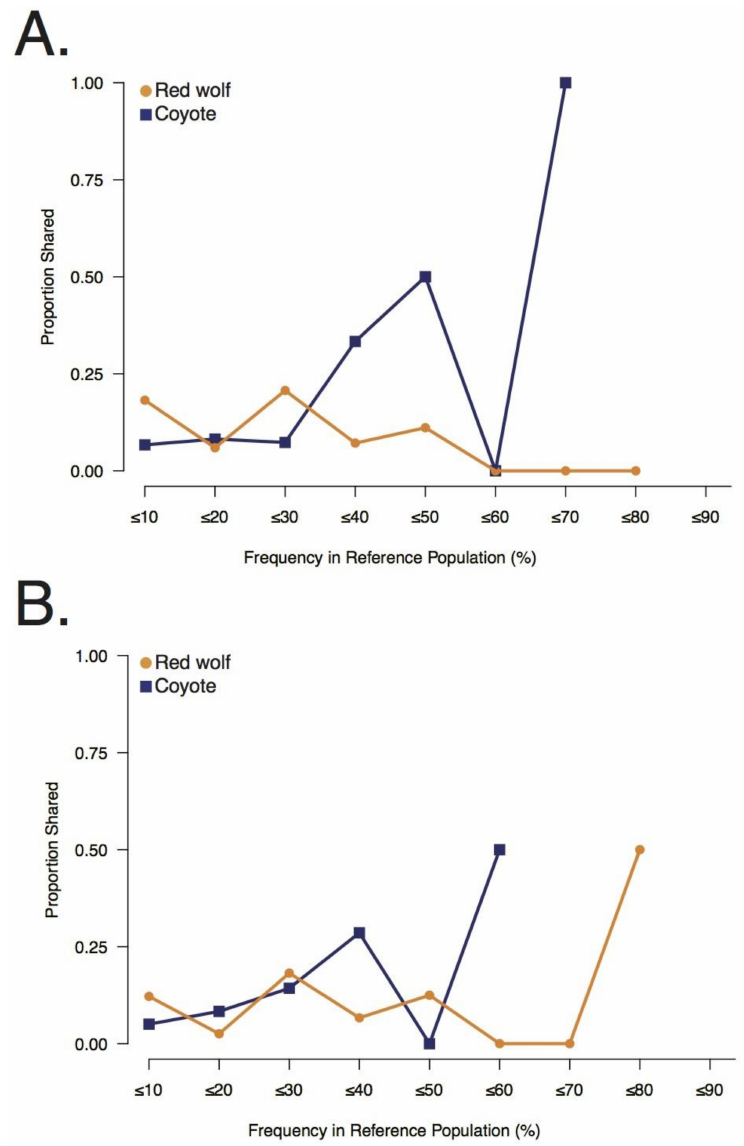
Figure 3. Sharing of red wolf and coyote private alleles with the two Galveston Island, Texas canids, ( A ) GI-1 and ( B ) GI-2, and their frequencies in their respective reference